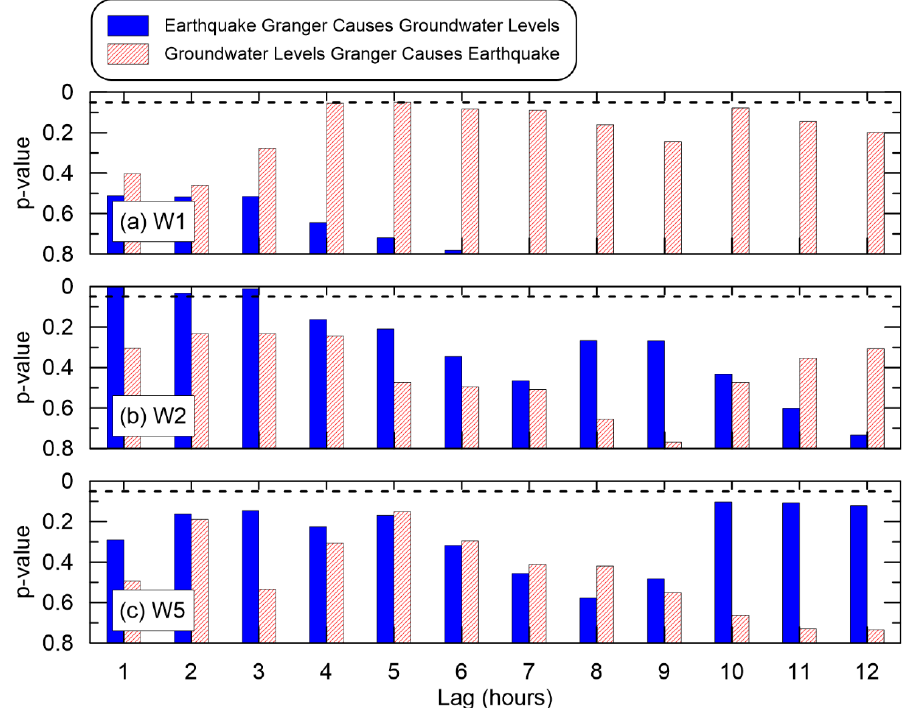
Figure 15. Results from Granger causality tests on wells ( a ) W1, ( b ) W2, and ( c ) W5 with respect to the earthquake.